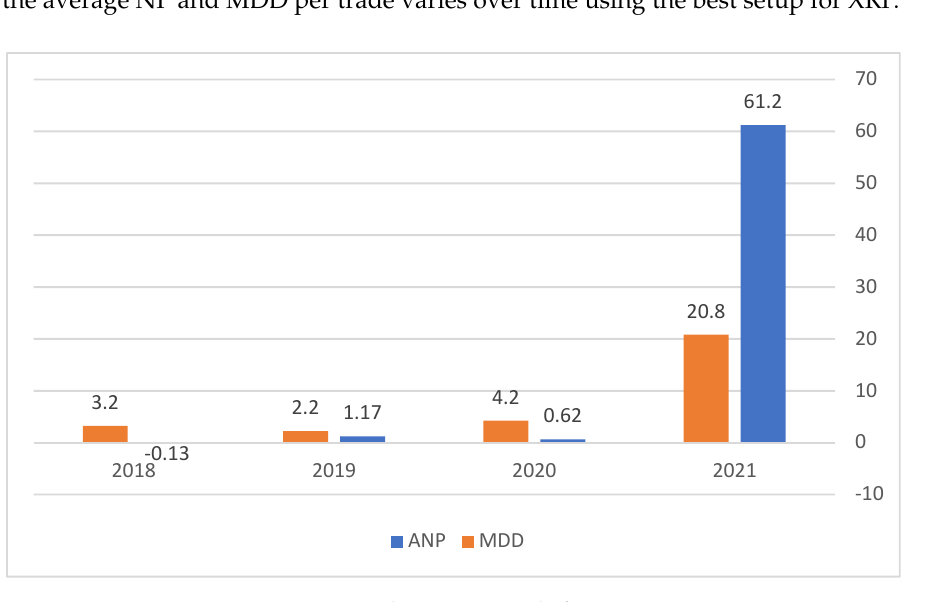
Table 5. Results for Cardano trades.